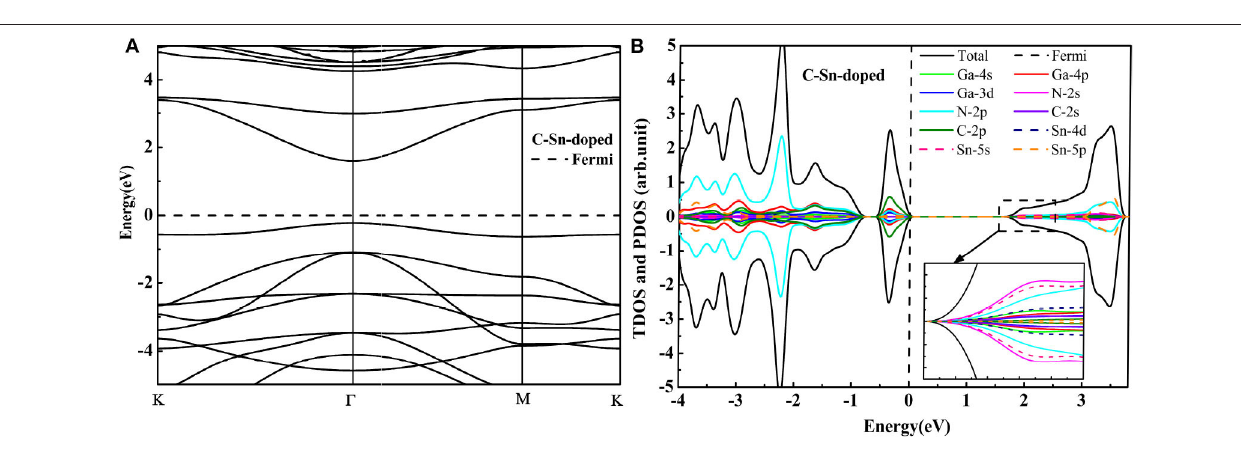
DOS of C-Sn doping is plotted in Figure 4B . It indicates